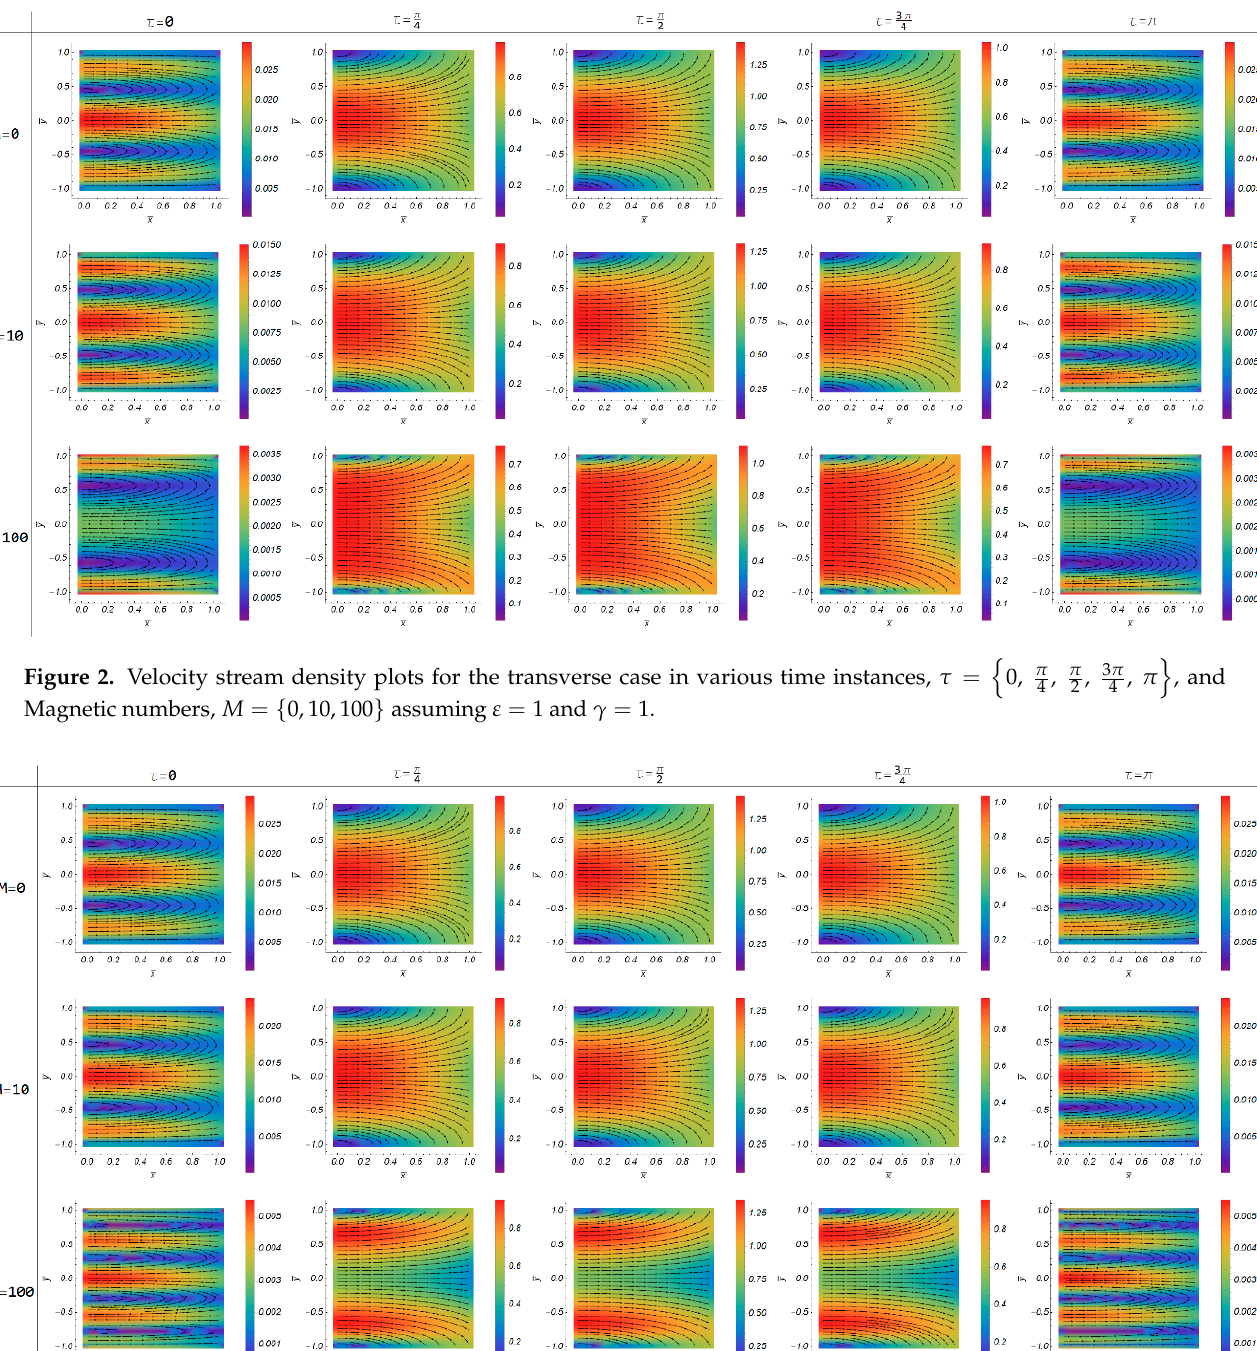
(cid:110) (cid:111) (cid:3095) , (cid:3095) , (cid:2871)(cid:3095) , 𝜋}, and Magnetic 0, π , π , 3 π , π , and Magnetic 2 4 4 (cid:2872) (cid:2870) (cid:2872)